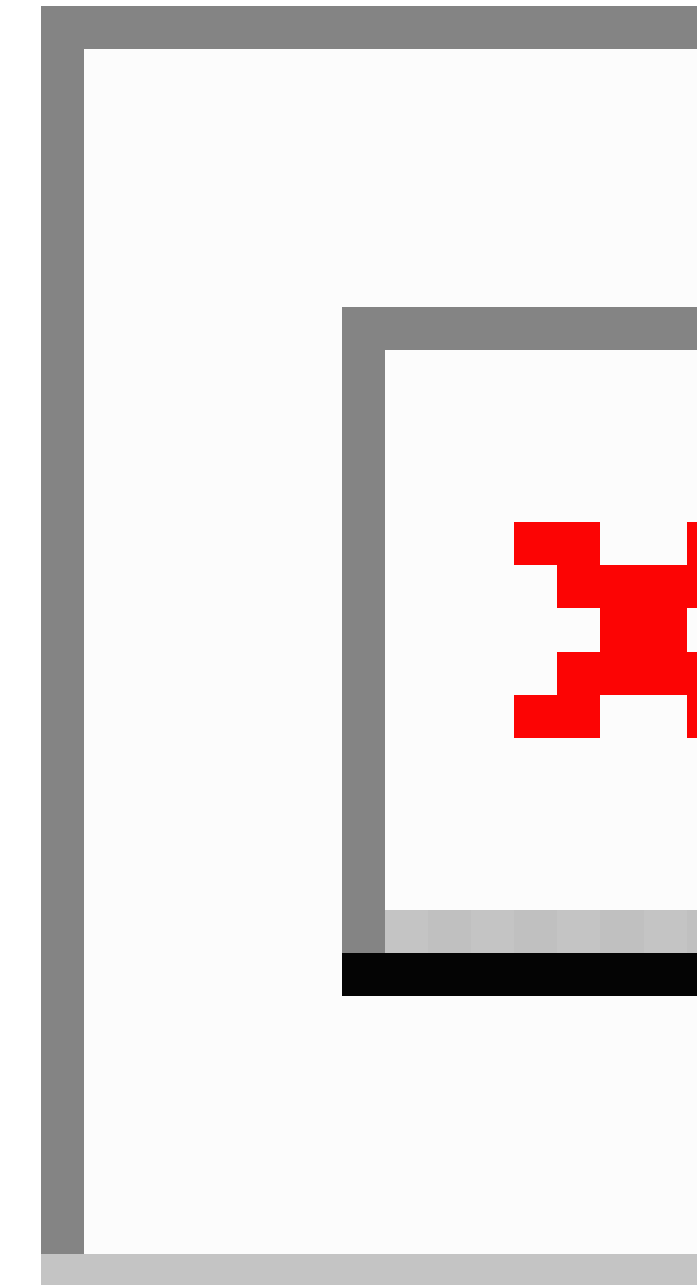
Figure 1. A 3-round eDelphi study for developing the CUE-tool. eDelphi: electronic